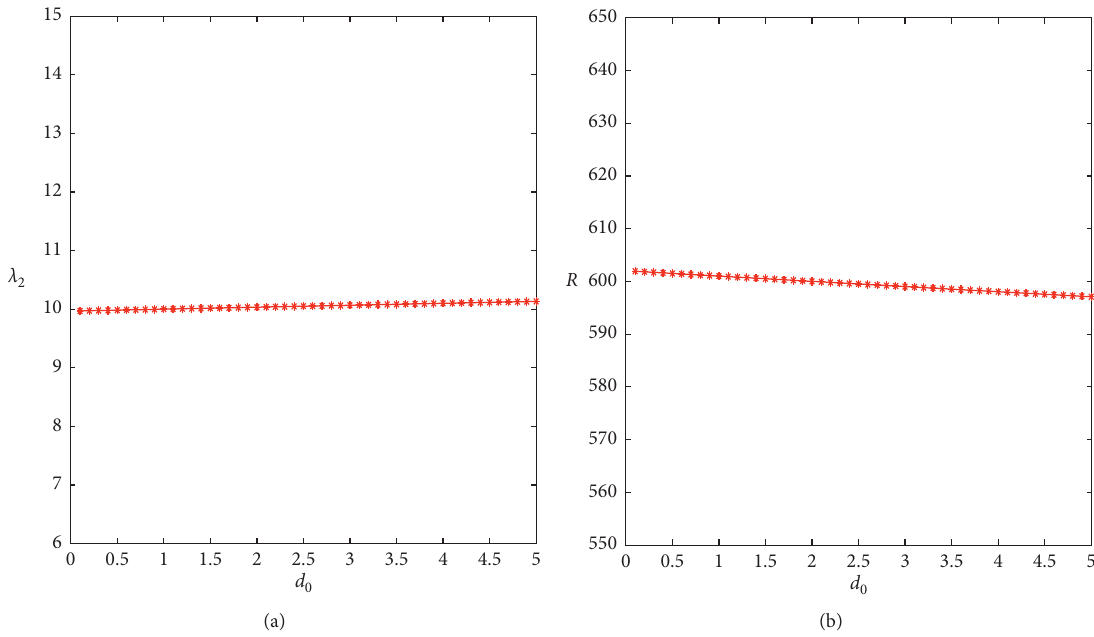
Figure 6: The synchronizability of multilayer star networks vs . varying the interlayer coupling strength d a < Md ). (a) λ 2 with respect to varying d 0 . (b) R with respect to varying d 0 .